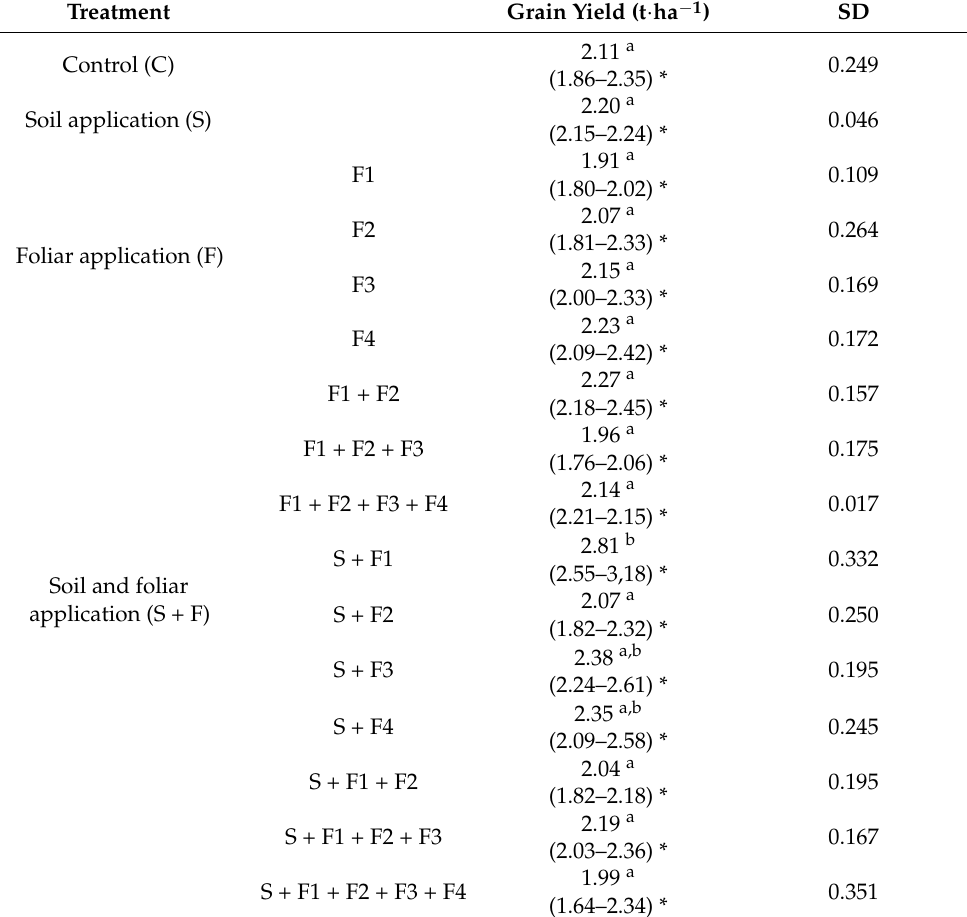
Table 3. Yield depending on